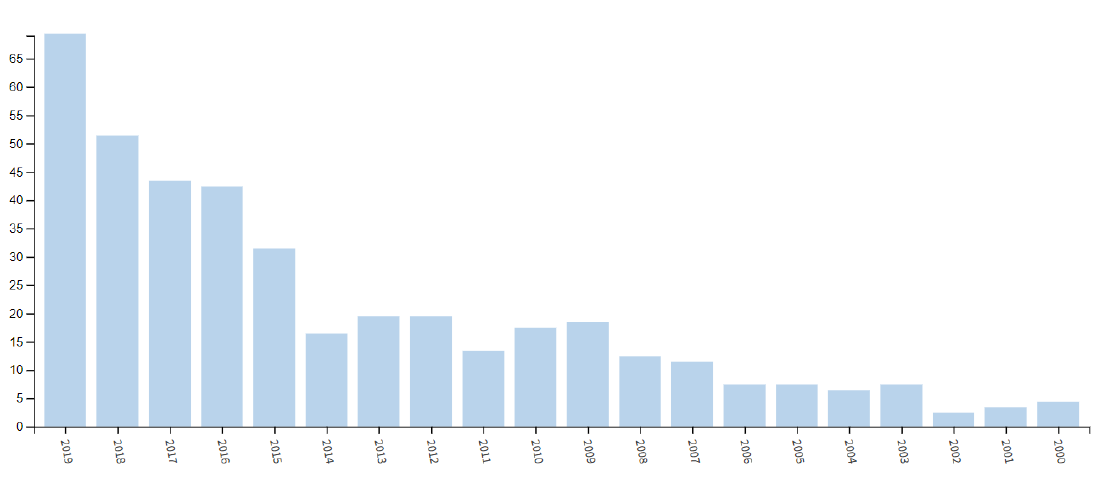
Figure 1. The number of publications (n = 408) on archaeological machine intelligence (MI) since 2000 (source, Web of Science).